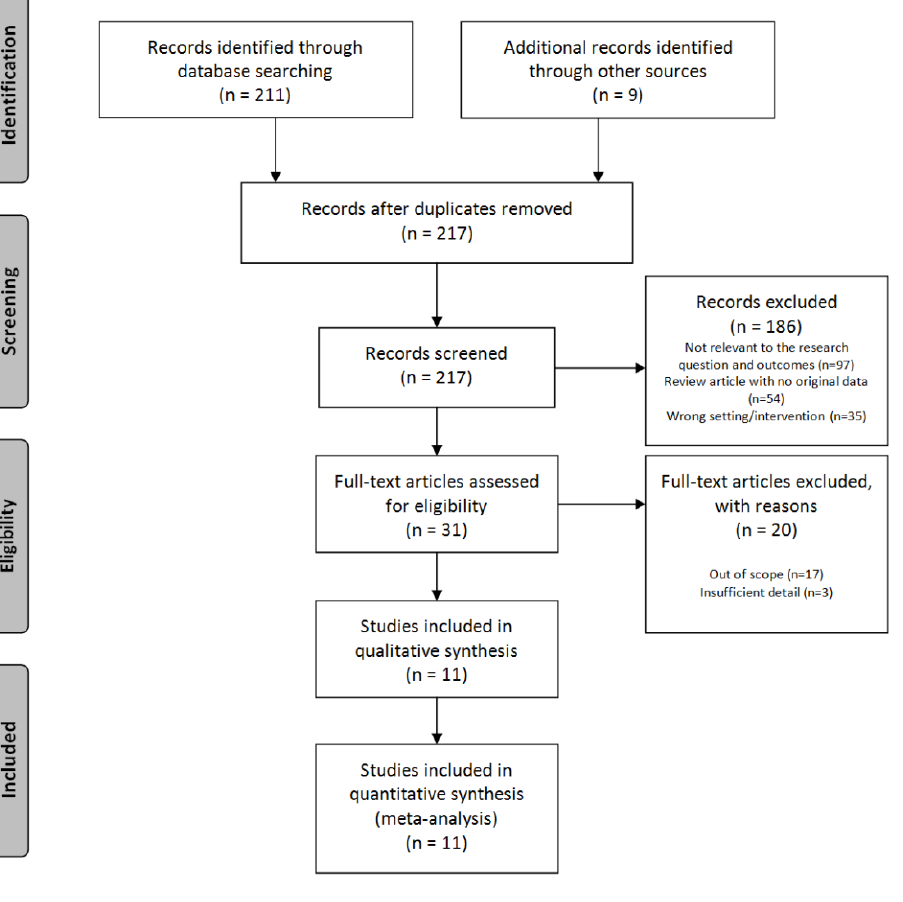
Table 1. Included studies concerning burnout neuroimaging.